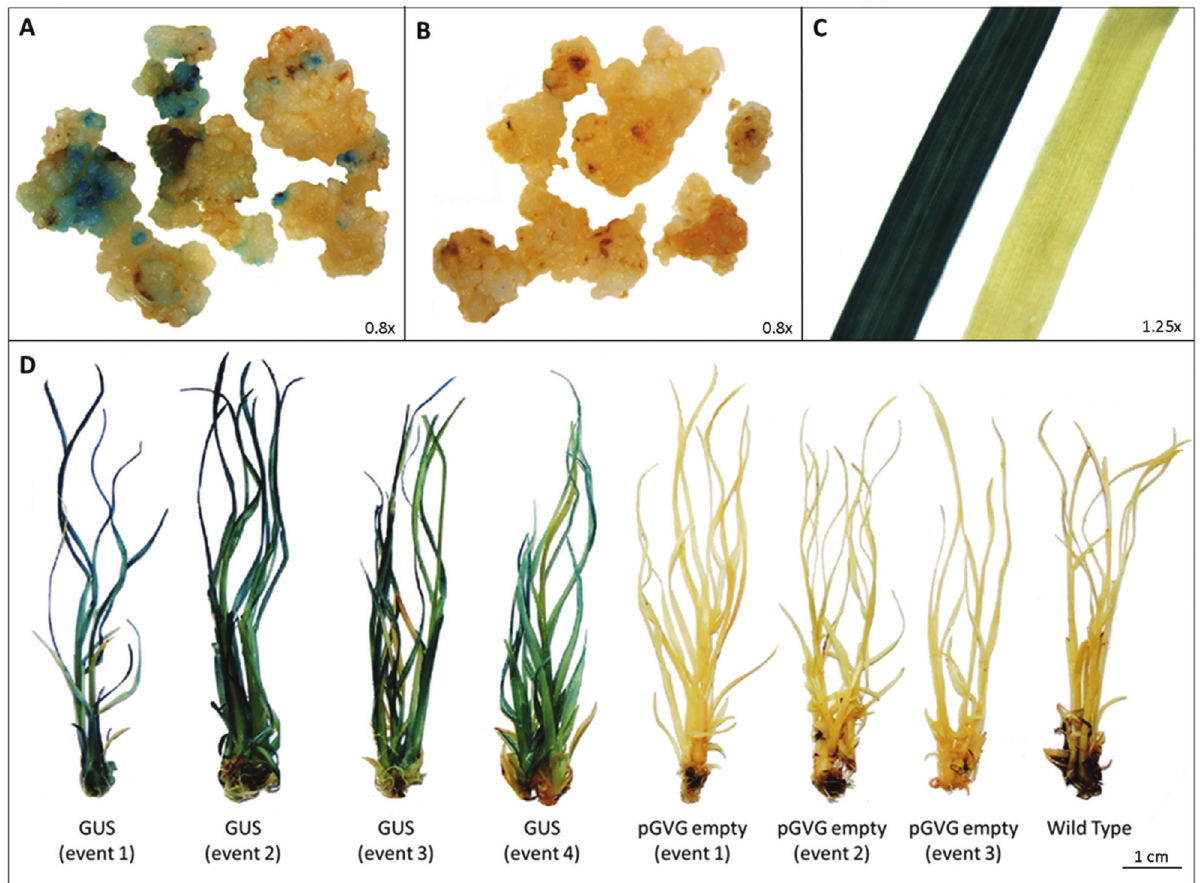
Figure 2 - GUS expression on transgenic sugarcane tissues obtained from Agrobacterium-mediated transformation system using the pGVG vector. Transformed (A) and untransformed (B) calli, three weeks after the co-culture period; (C) leaves from a transformed (left) and untransformed (right) plant; (D) transformed (GUS, pGVG empty) and untransformed (Wild Type) plants, 4 months after the co-culture period.